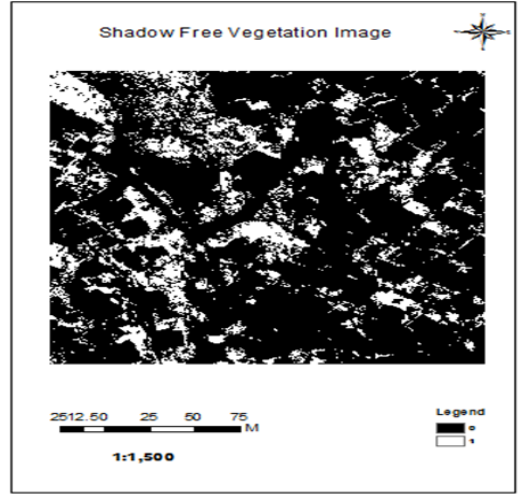
Figure 10. Shadow free vegetation image.